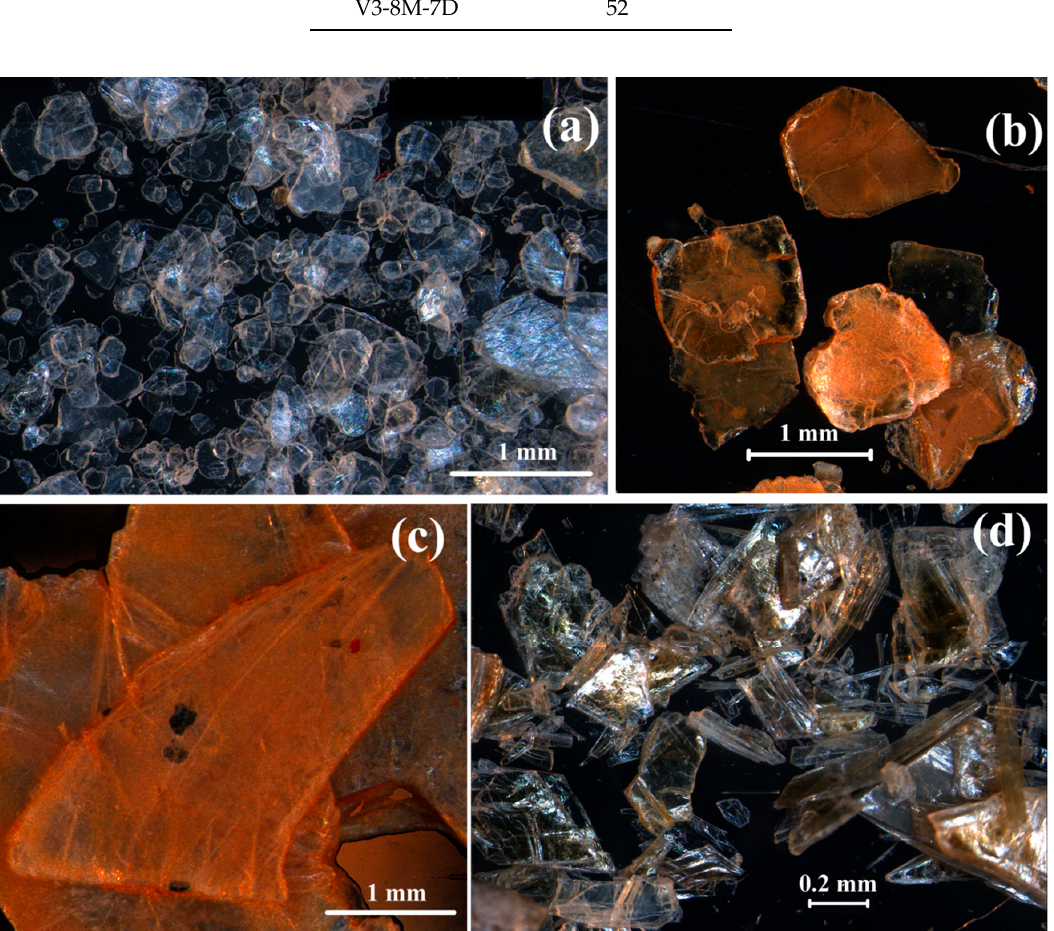
Figure 1. Micrographs of treated vermiculites: ( a ) V1-4M-7D; ( b ) V2-4M-7D; ( c ) iron oxide particles in V2-4M-7D; ( d ) V3-4M-7D.